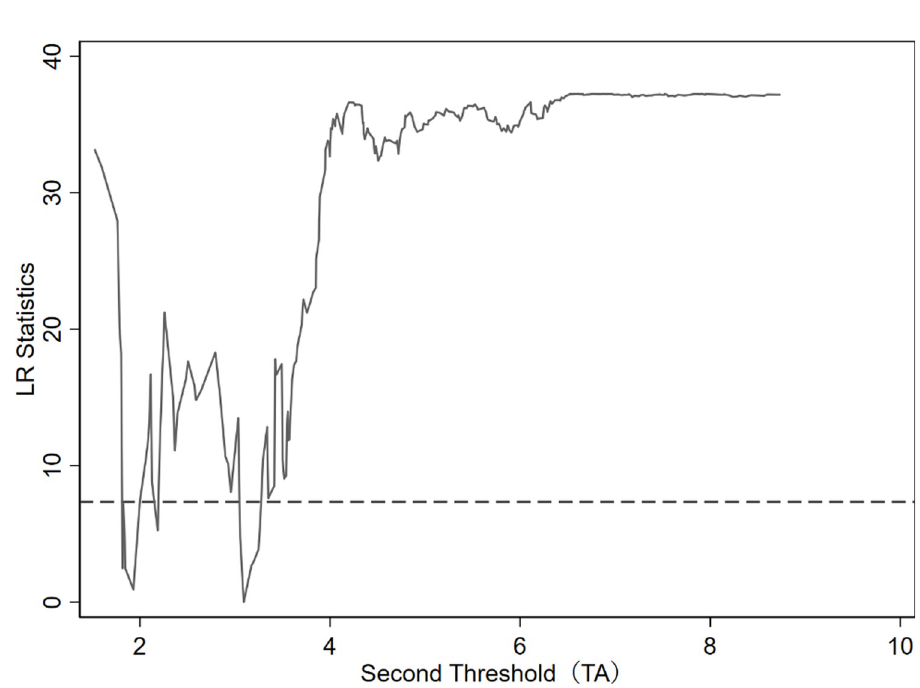
Fig 2. The second threshold estimate and confidence